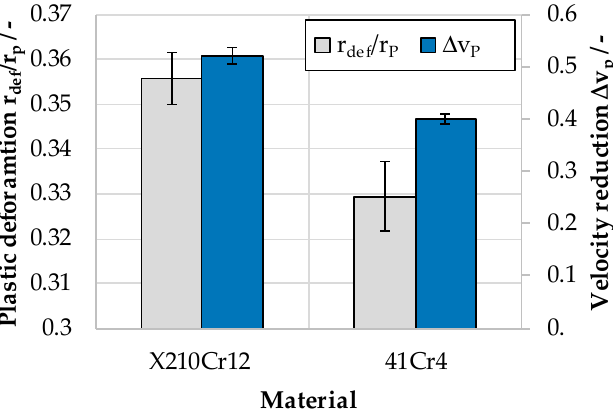
Figure 7. Determined plastic deformation and velocity reduction due to impact in particle-oriented peening.